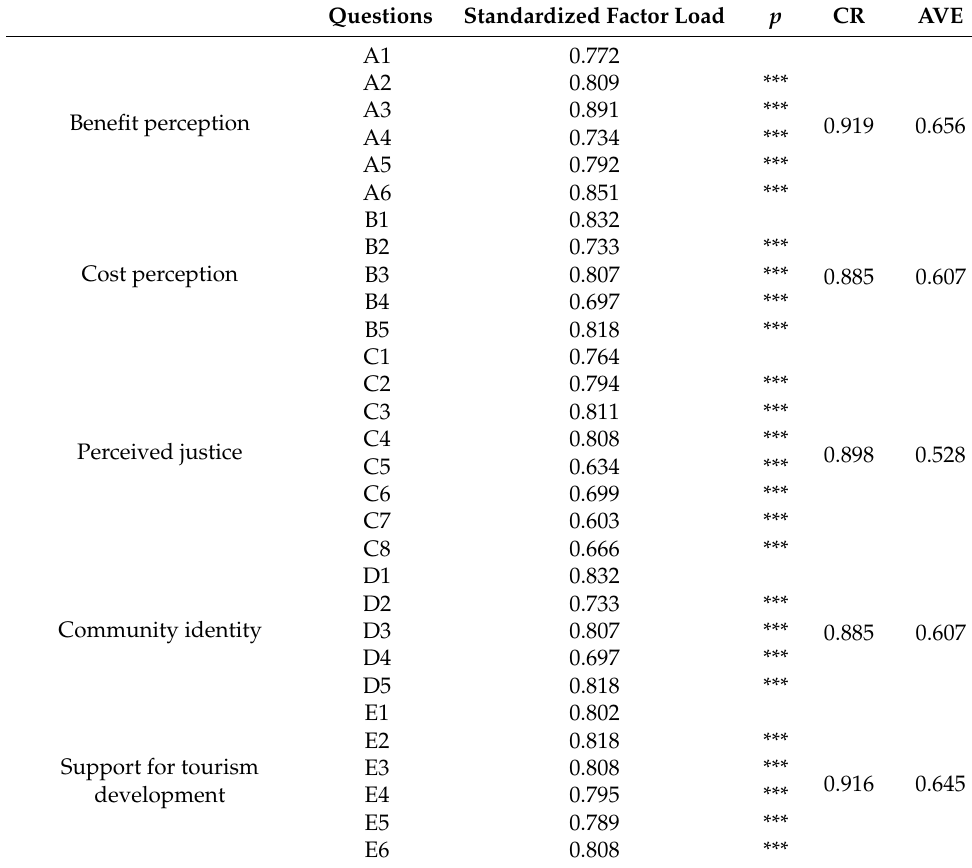
Table 4. The results of confirmatory factor